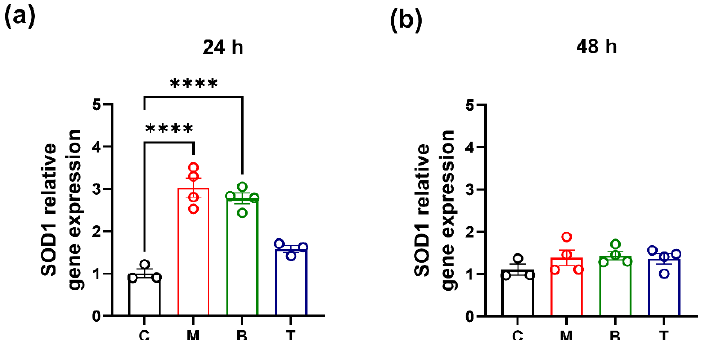
Figure 3. SOD1 relative gene expression after treatment with 10 µ M morphine (M), 0.25 µ M buprenorphine (B) or 10 µ M tapentadol (T) in SH-SY5Y cells at 24 h ( a ) and 48 h ( b ). Data, expressed as the mean ± SEM of three/four biological replicates for each treatment, represent 2 − DDCt values and are analyzed by one-way ANOVA followed by Dunnett’s multiple comparisons test ( **** p < 0.0001 vs. control (C)).